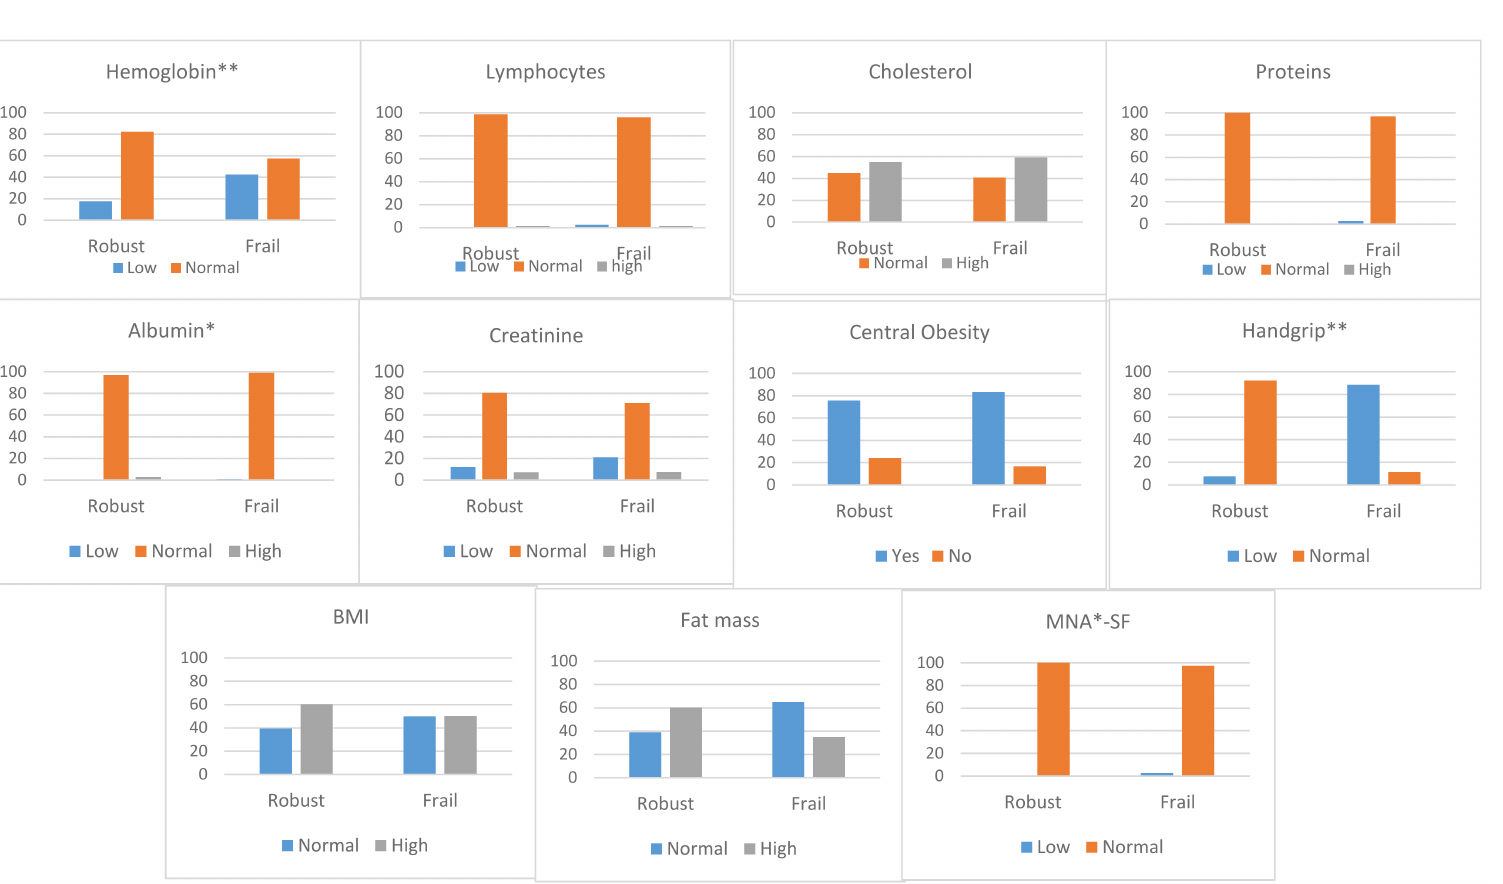
Figure 2. Nutritional assessment in robust vs. prefrail / frail groups, according to established cuto ff s for normality. * p < 0.05; ** p < 0.001. Cuto ff values were: for hemoglobin, low < 13.5 g / dL in men and < 12.5 g / dL in woman, normal ≥ 13.5 g / dL in men and ≥ 12.5 g / dL in women; for total lymphocytes count, low < 1 × 103 / mm 3 , normal 1–4.8 × 103 / mm 3 , high > 4.8 × 10 3 / mm 3 ; for cholesterol, normal < 200 mg / dL, high ≥ 200 mg / dL; for creatinine, low < 0.7 mL / min, normal 0.7–1.3 mL / min, high > 1.3 mL / min; for proteins, low < 6 mg / dL, normal 6–8.3 mg / dL, high > 8.3 mg / dL; for albumin, low < 3.4 mg / dL, normal 3.4–5.4 mg / dL, high > 5.4 mg / dL; for central obesity, waist circumference in women ≥ 88 cm and in men ≥ 102 cm; for handgrip following Fried criteria; for BMI, normal < 30 kg / m 2 , high ≥ 30 kg / m 2 ; for body fat percentage, high in women ≥ 42% and in men ≥ 30%, normal scores below by gender, and for the MNA-SF, low ≤ 11, normal ≥ 12